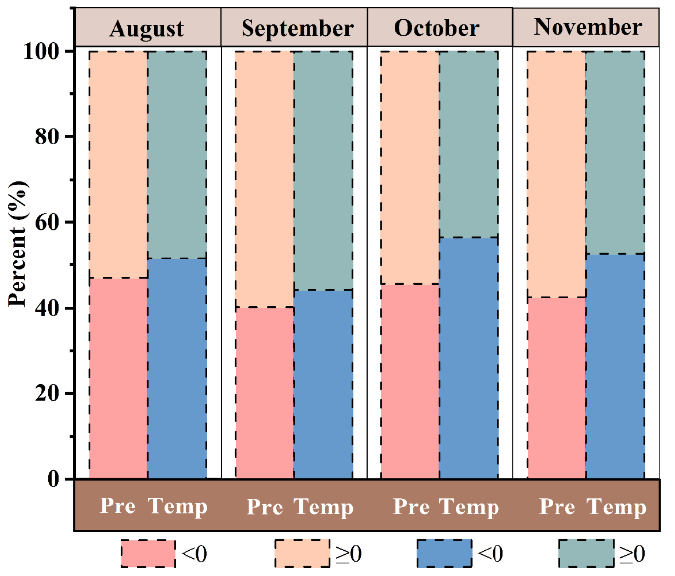
Figure 9. Graded ratios of the positive/negative correlation coefficients between the EOS and pre ‐ cipitation/temperature.